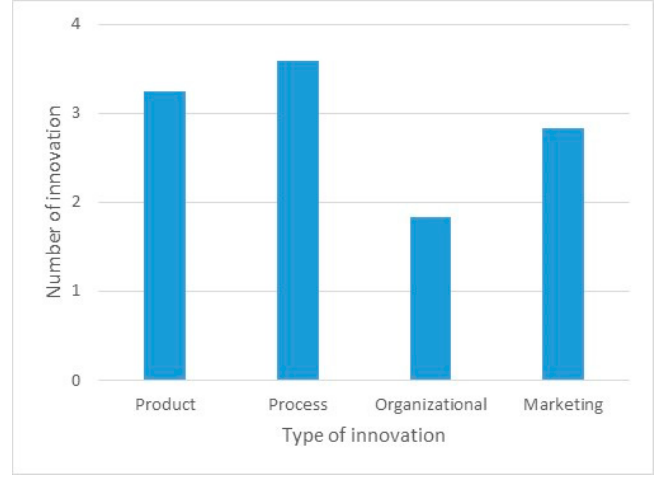
Figure 1. Average number of innovations rolled out over the past 3 years by type.